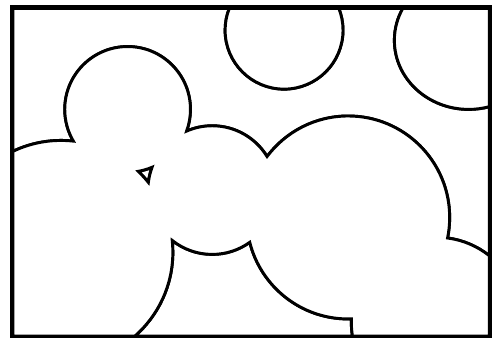
Figure 1 . 2D explanation of envelope approximation, the black lines represent bubble walls. Only uncollided parts of bubbles are regarded as GW sources, and the energy-momentum tensor of the collided parts of bubbles vanish at